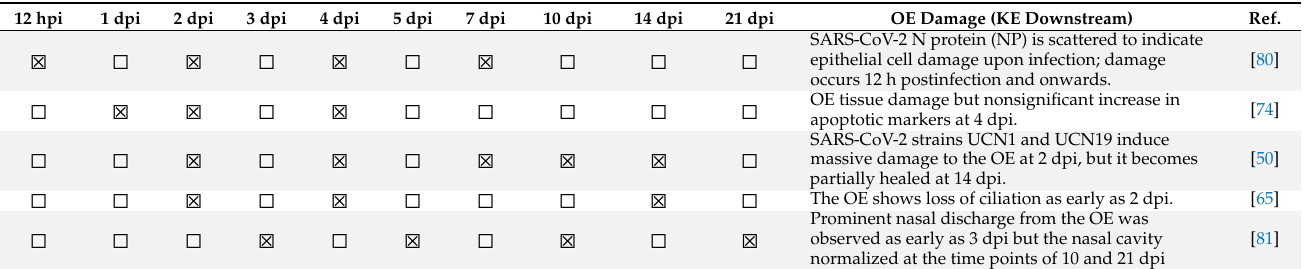
Dpi—day post inoculation; KE—key events.